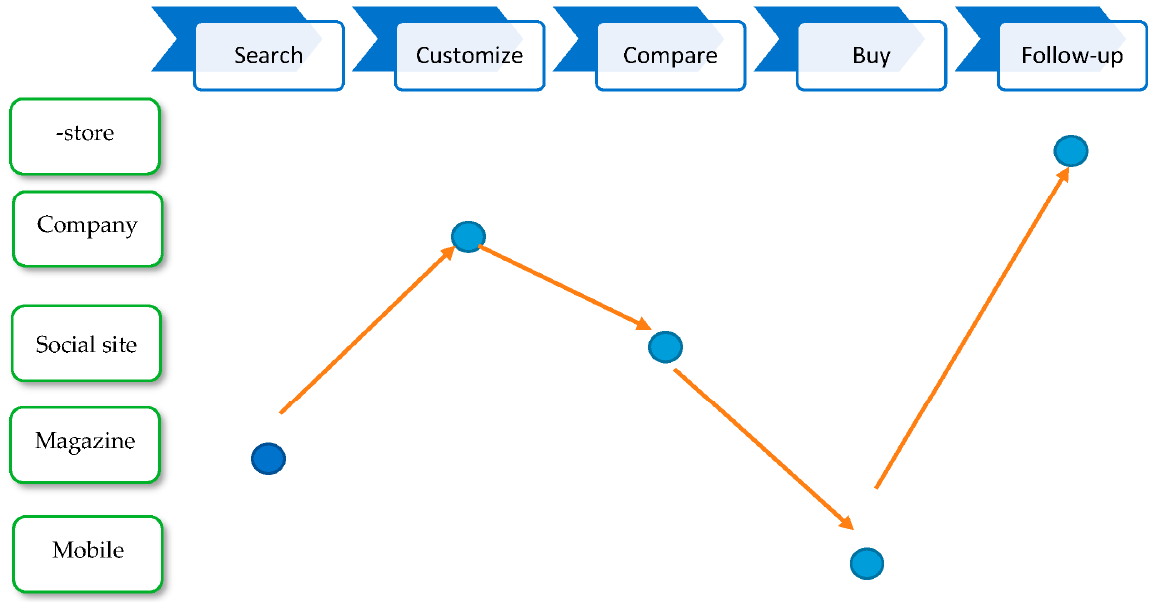
Figure 2. A Customer Journey Map in the Omni-Channel.